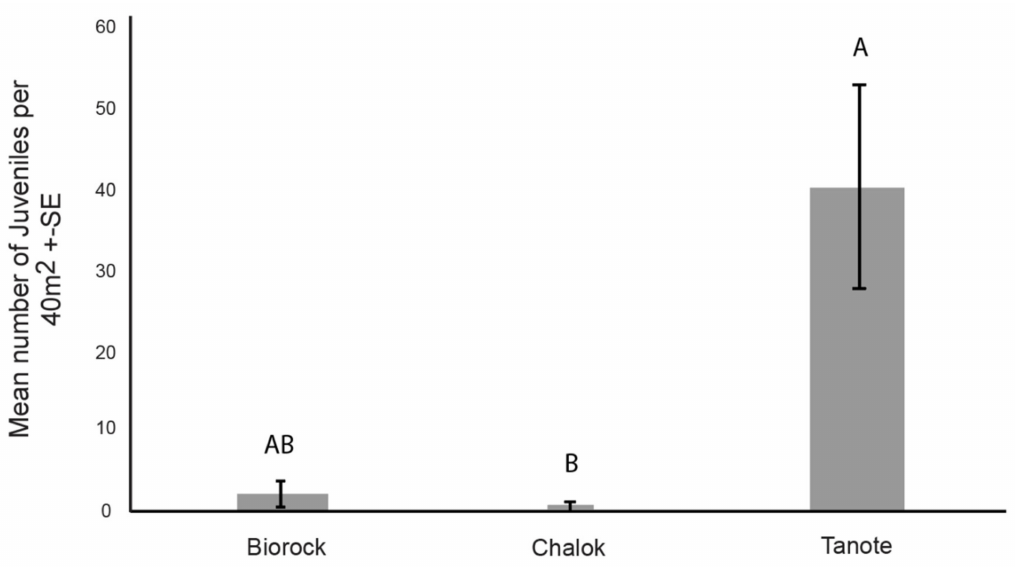
Figure 6. Mean number of juvenile corals counted per 40-m 2 belt transect ( ± SE) compared among the three restored sites in Koh Tao (Thailand). Restoration designs varied among the three sites, i.e., corals were transplanted: onto electrified steel frames at the Biorock site, onto steel frames and into glass bottles embedded in concrete in Chalok, and onto concrete reef balls in Tanote. Letters above each histogram indicate whether mean values di ff er significantly (di ff erent letters) or are statistically indistinguishable (same letters). n = 9 transects per